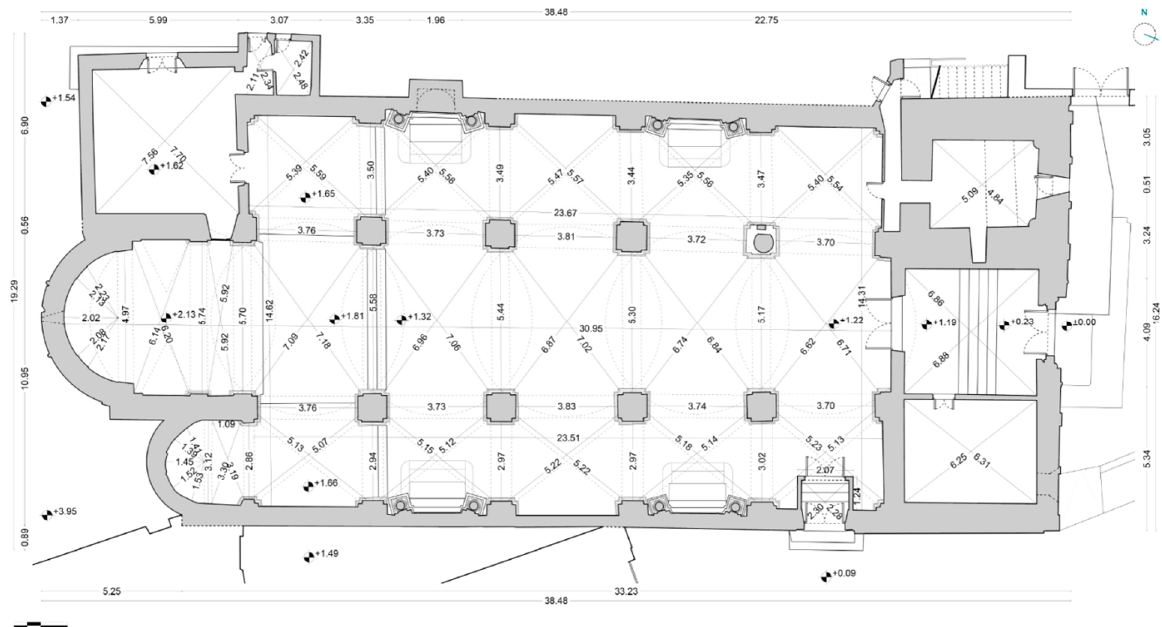
Figure 5. Geometric plan of the whole building at 4.00 m height.